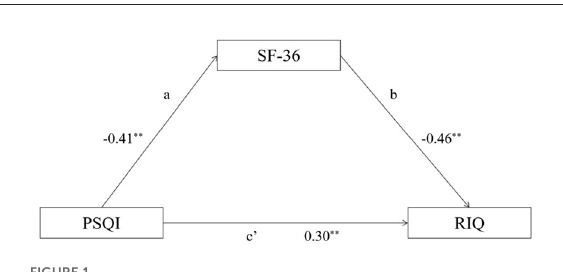
FIGURE1 The path diagram of mediating effect of SF-36 between PSQI and RIQ.